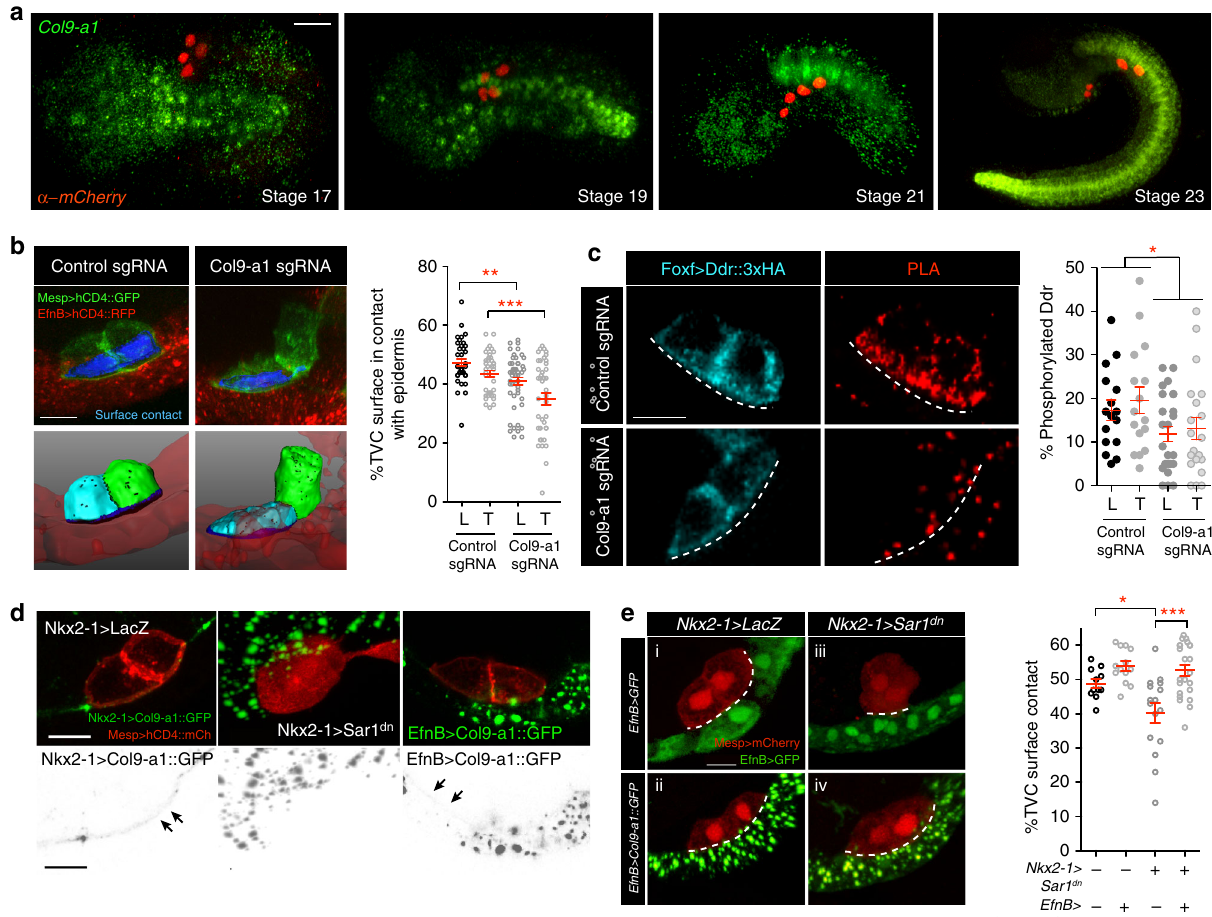
Fig. 4 Col9-a1 is an endodermal cue that promotes TVC adhesion and Ddr activation. a Endogenous expression of Col9-a1 in the developing Ciona embryo. Micrographs are oriented with anterior to the left, an in situ RNA probe is used to visualize Col9-a1 transcripts. B7.5 lineage is visualized using Mesp> H2B:: mCherry . Scale bar = 60 μ m. b CRISPR mutagenesis of the Col9-a1 locus in the endoderm using a Foxd -driven Cas9. Blue surfaces are sites of contact. Quantitation of TVC surface area in contact with epidermis adhesion is shown on the right. Statistical analysis using two-way ANOVA and the Bonferroni post hoc test. S.E.M. is shown. Scale bar = 10 μ m. c PLA to detect phosphorylated full-length Ddr under control (EBF CRISPR) and CRISPR conditions targeting the Col9-a1 locus for mutagenesis. Statistical analysis using two-way ANOVA. S.E.M. is shown. Scale bar = 10 μ m. d Secretion and localization of an endodermally/epidermally expressed Col9A::GFP fusion. TVC membrane is visualized using Mesp > hCD4::mCh . First panel shows secretion and localization of Col9::GFP fusion. Middle panel shows block in endodermal secretion using Sar1 dn . Gray scale panels show the corresponding inverted GFP channel. Arrows point to the accumulation of Col9-a1 in the extracellular matrix. Scale bar = 10 μ m. e Rescue of Nkx2 – 1 > Sar1 dn TVC adhesion defects with epidermally expressed Col9-a1 . Epidermis is marked with EfnB > GFP . Note that in the lower panels EfnB > GFP is expressed but is less bright in comparison to the Col9-a1::GFP traf fi cking vesicles. Dotted line outlines the surface of contact. Quantitation of TVC adhesion is shown to the right of the micrographs. Scale bar = 10 μ m. Statistical analysis using one-way ANOVA followed by the Bonferroni post hoc test. S.E.M. is shown. For b , c data are pooled from three biological replicates, e is pooled from two biological replicates. All images are oriented with leader TVC to the left. * p < 0.05, ** p < 0.005, *** p < 0.0005.